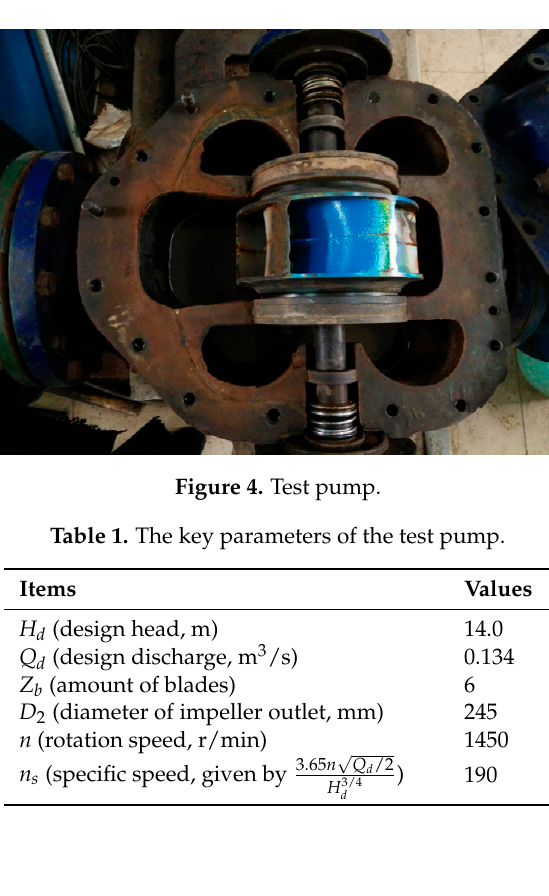
Figure 3. Closed-circulation test system for double-suction centrifugal pump. Description: (1) Supply pipe of cooling water; (2) adjusting valve; (3) electric motor; (4) water tank; (5) water cooling jacket; (6) sand agitator; (7) inlet valve; (8) inlet pipe; (9) pressure transducer; (10) double-suction centrifugal pump; (11) asynchronous motor; (12) pressure transducer; (13) outlet pipe; (14) outlet valve; (15) electromagnetic flowmeter.